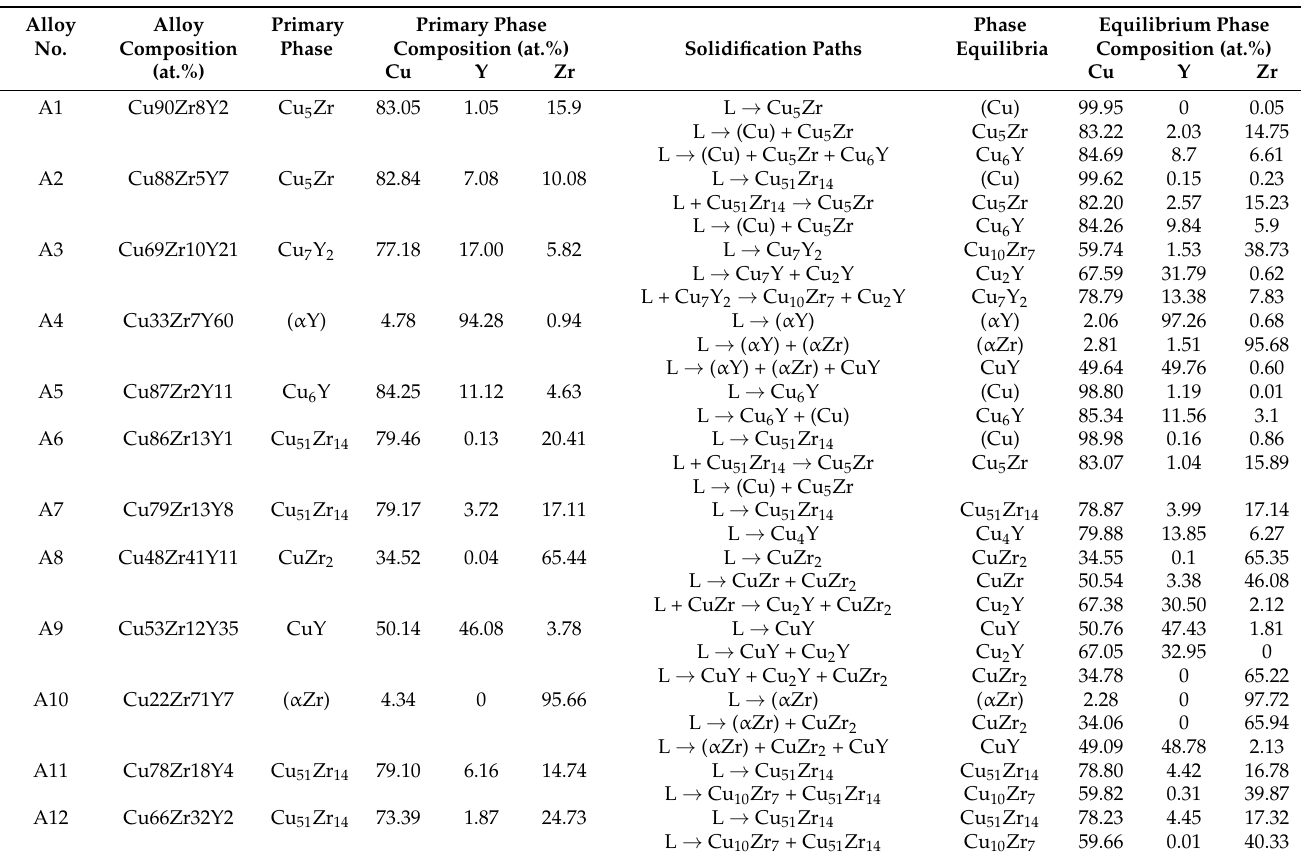
Table 1. Summary of the experimental data for the Cu–Zr–Y system.